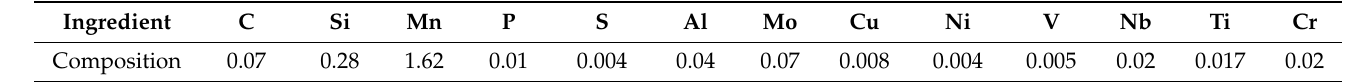
Table 1. Chemical composition of high-strength low-alloy steels (mass, %).